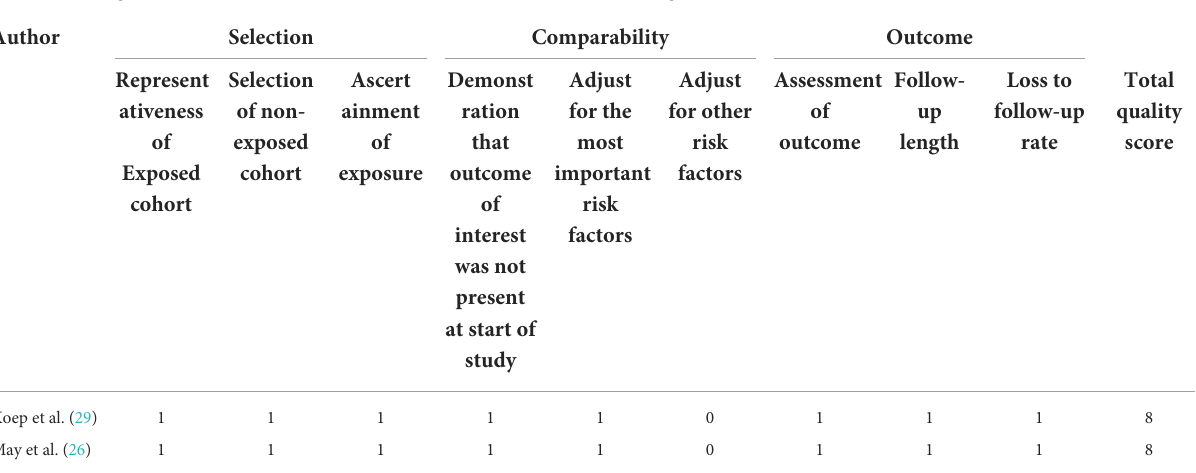
TABLE 4 Quality assessment of the observational studies included in the meta-analysis (The NOS